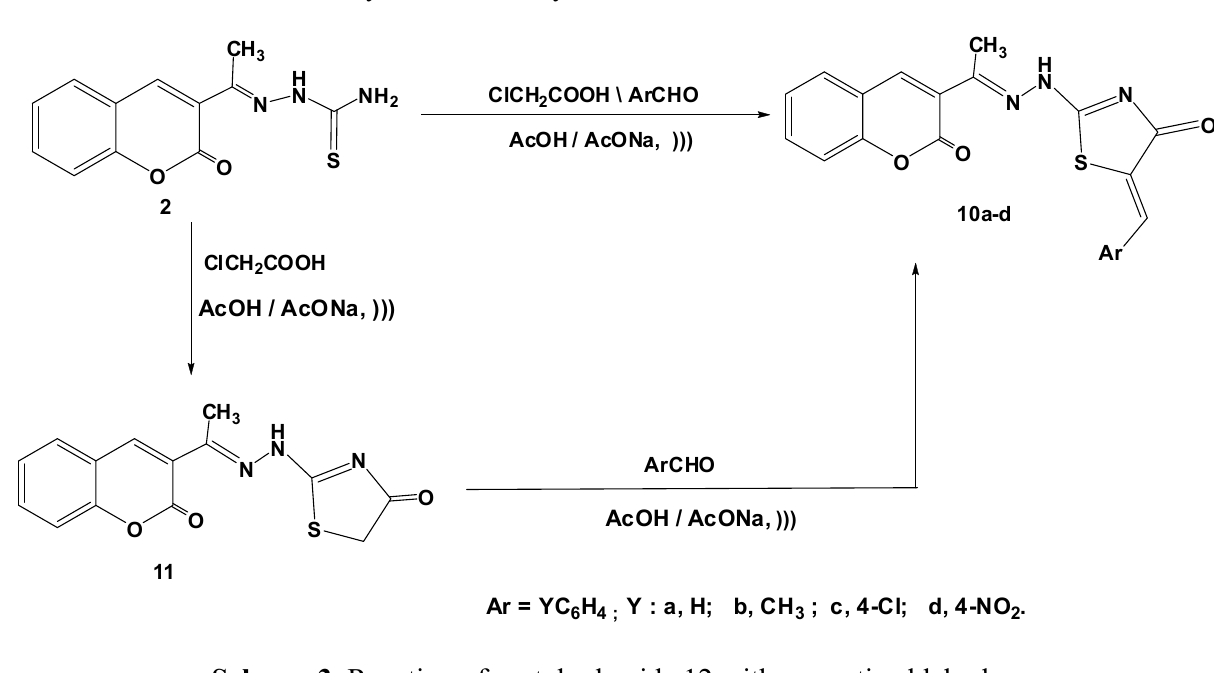
Scheme 3. Reaction of acetohydrazide 12 with aromatic